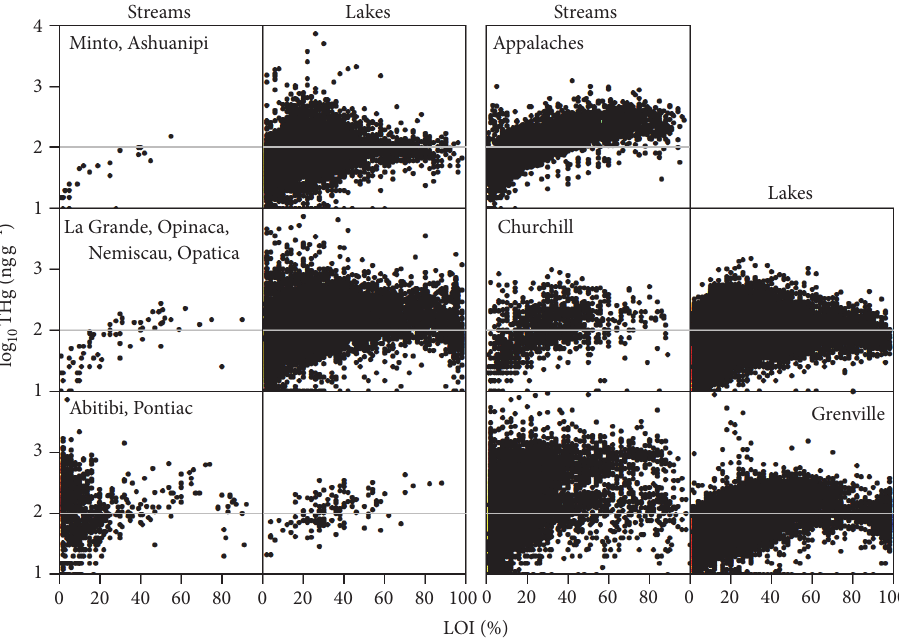
Figure 4: Scatterplots of lake and stream sediment THg (ng g −1 , log 10 scale) versus LOI (%) by Quebec survey zones.